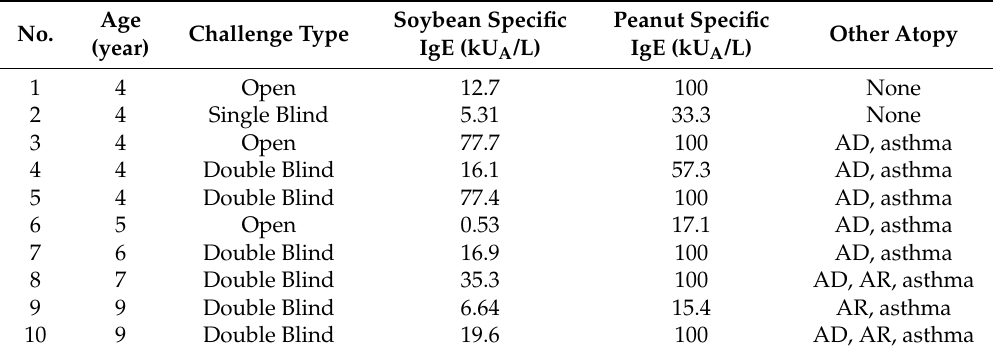
Table 1. Characteristics of peanut and soybean-allergic subjects. AD: atopic dermatitis, AR: allergic rhinitis. Age No. Challenge (year)